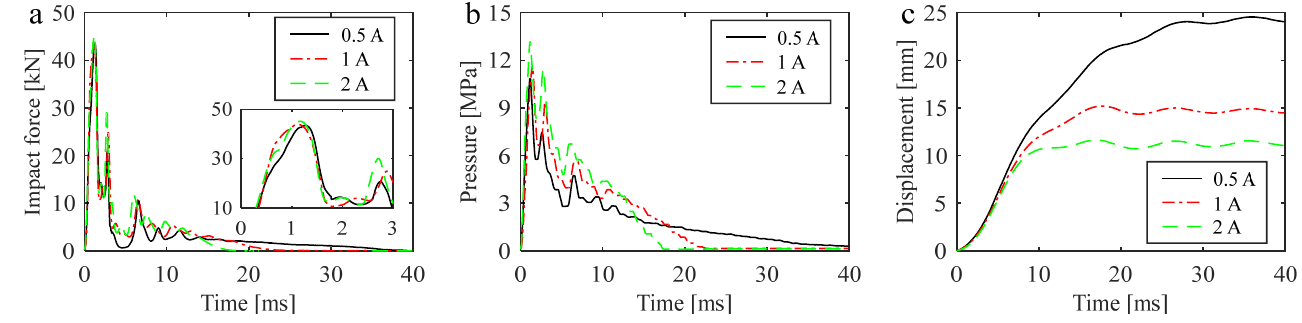
Figure 8. Time history of the impact force, pressure, and displacement for different excitation currents under the drop height of 0.7 m.